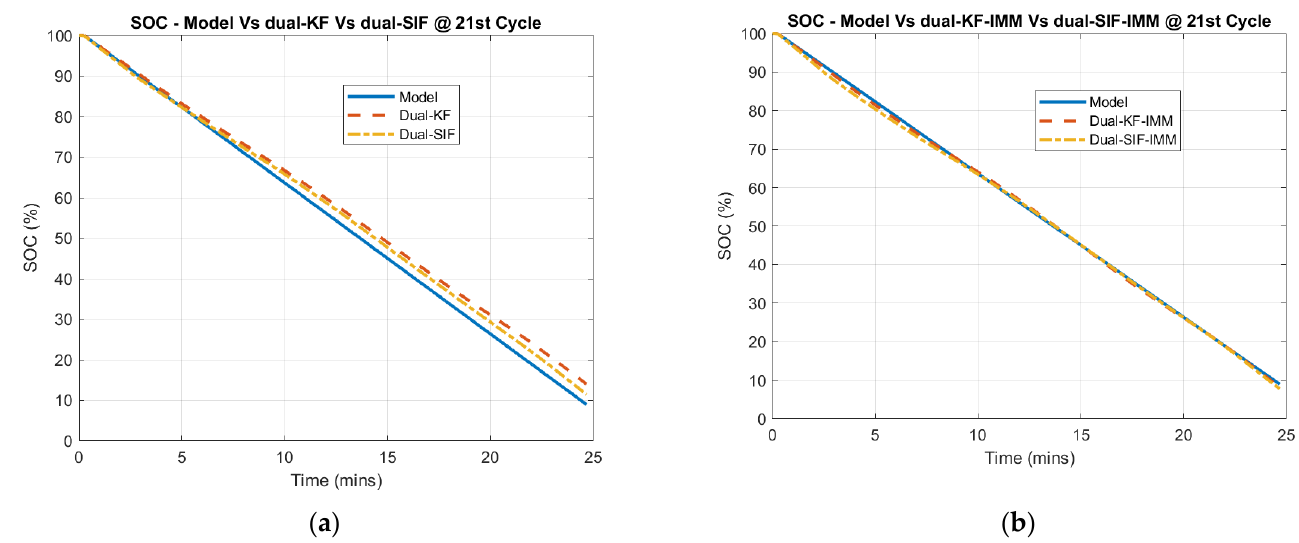
Figure 15. ( a ) dual-KF and dual-SIF SOC estimates at cycle 21. ( b ) Dual-KF-IMM and dual-SIF-IMM SOC estimates at cycle 21.